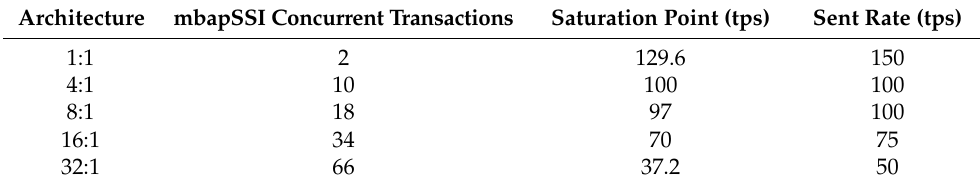
Table 6. Determination of the boot-time overhead of mbapSSI over